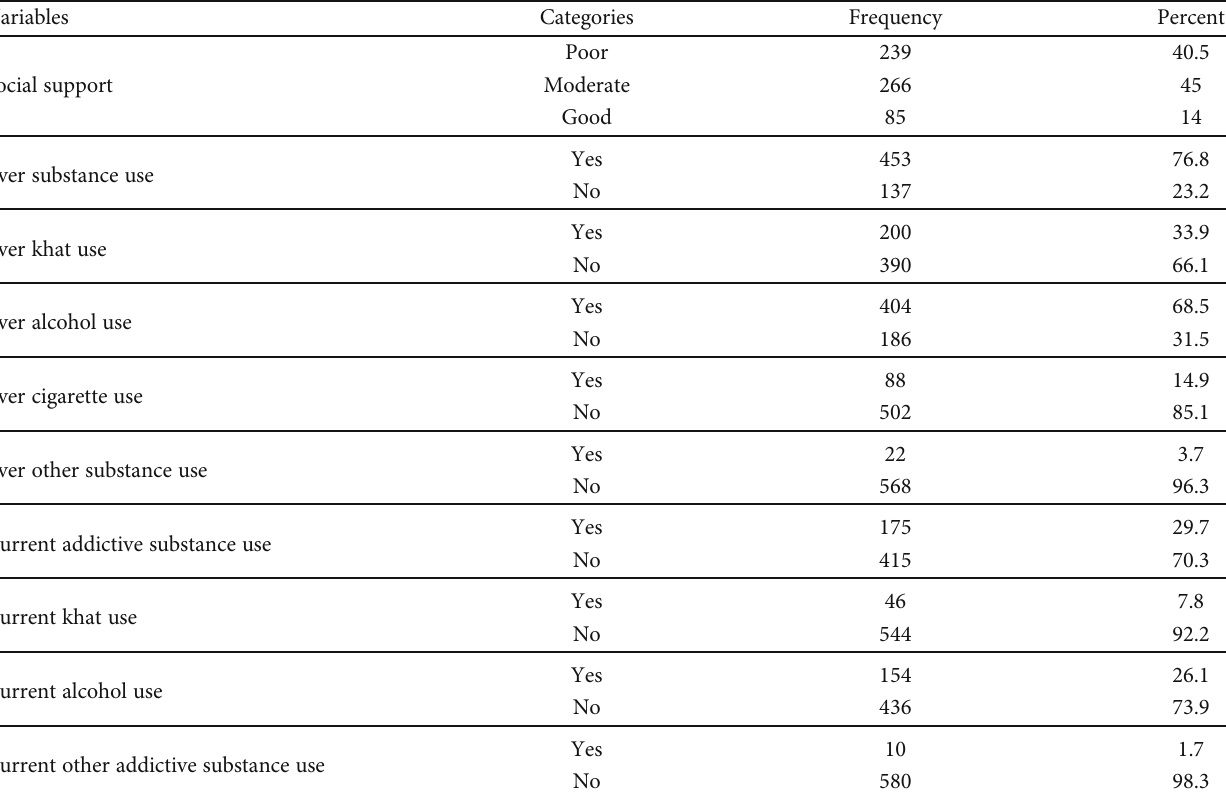
Table 3: Psychosocial and substance use characteristics of respondents admitted at medical and surgical wards of SPHMMC, Addis Ababa, Ethiopia, 2019 ( n = 590